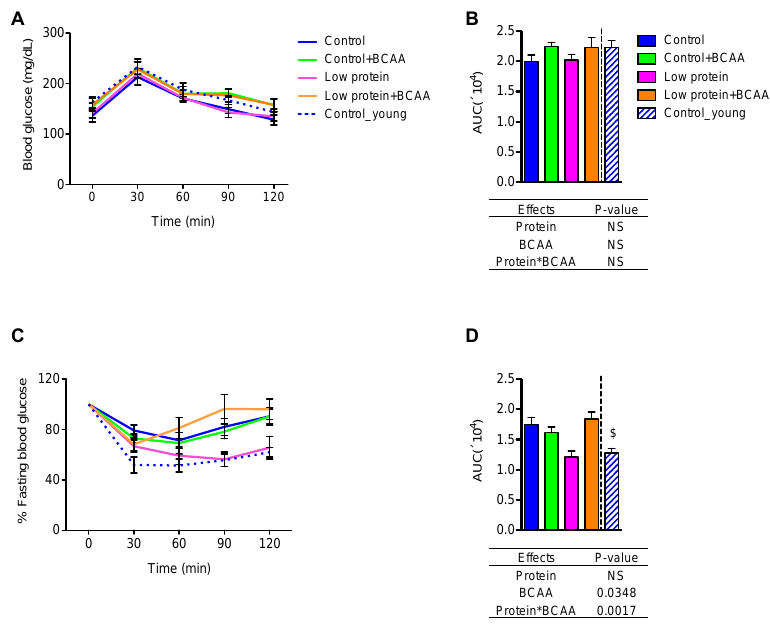
Figure 2. The low protein diet improved insulin tolerance but did not affect glucose tolerance. Blood glucose across time ( A ) and area under the curve (AUC) ( B ) were recorded calculated from the GTT. The response to insulin as a percentage of fasting blood glucose was calculated for the ITT time course ( C ) and the corresponding AUC ( D ). Data represent mean ± SEM ( n = 8 – 12 mice/group). Statistical analyses of main effects (protein and BCAA) and interactions (protein*BCAA) are shown below panels ( B , D ). $ p < 0.05 between the young and the old control groups by Student ’ s t test. GTT: glucose tolerance test; ITT: Insulin tolerance test.